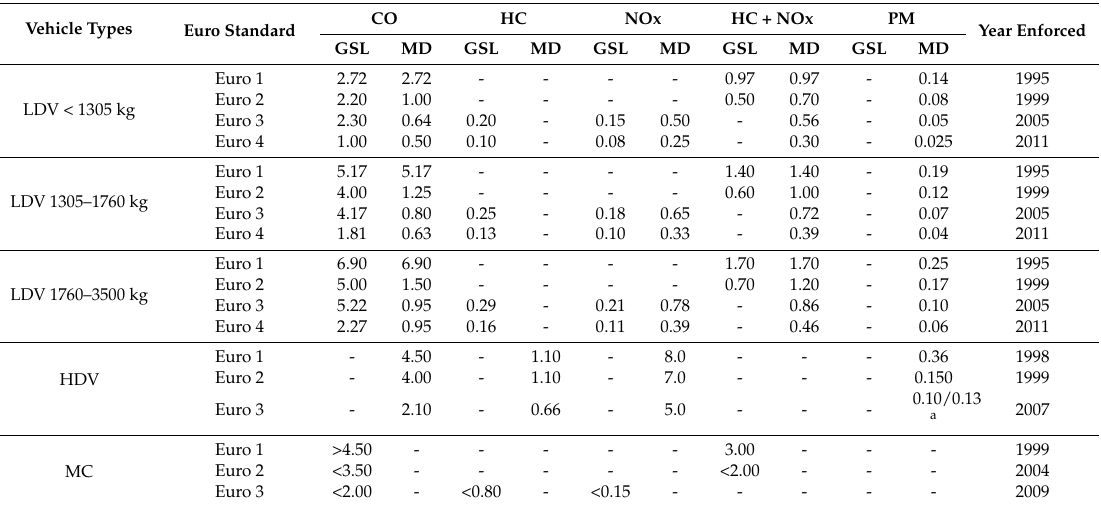
Table 3. Euro Emission standard for each mode type